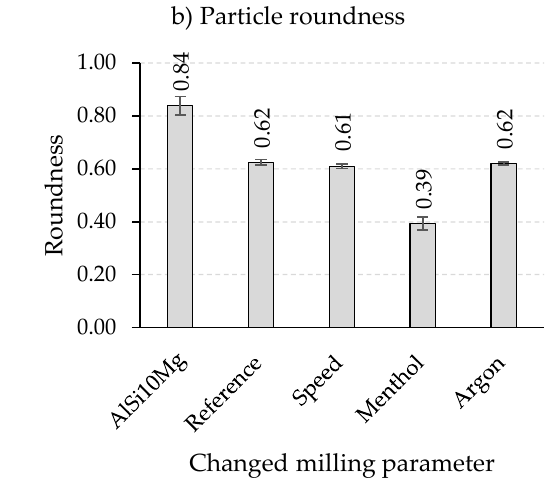
Figure 6. Results of ( a ) mean particle area and ( b ) roundness of composite powders produced with different milling parameters.